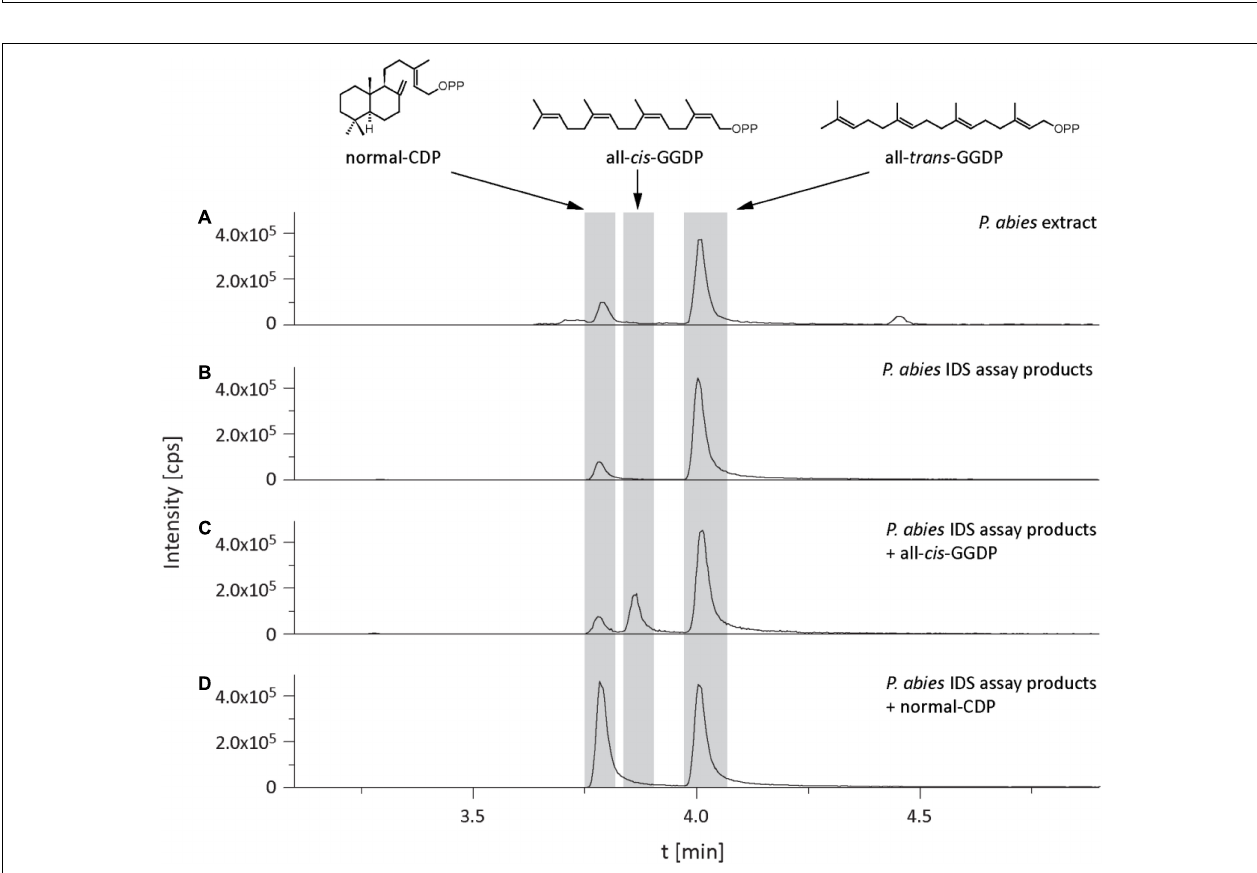
FIGURE 7 | Identification of copalyl diphosphate (CDP) in Picea abies bark extracts and in IDS assays of total protein extracts with IDP and DMADP as substrates. LC-MS/MS chromatograms [m/z: 449/79] of extracts of (A) bark tissue, (B) IDS assay, (C) IDS assay plus all- cis -GGDP, (D) IDS assay plus normal -CDP.